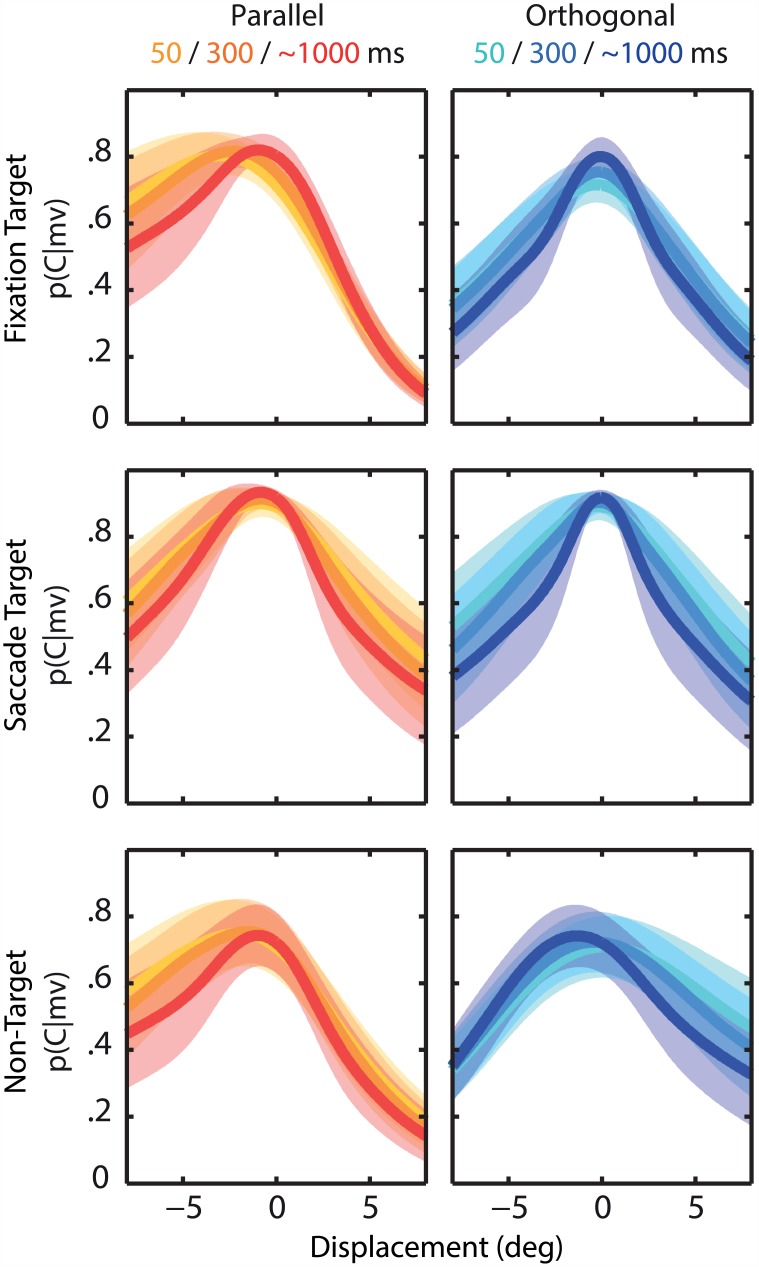
Inferred probability of a common cause p(C|mv) as a function of target displacement.Probabilities are based on the best-fit parameters, separated by target location (rows: FT, ST, NT), displacement directions (columns: parallel/orthogonal) and postsaccadic viewing duration(in color). Shown are the mean values across participants and standard error (shaded areas). This probability, which can be interpreted as the complementary probability of perceiving the displacement, optimally weights the integration and segregation strategy.